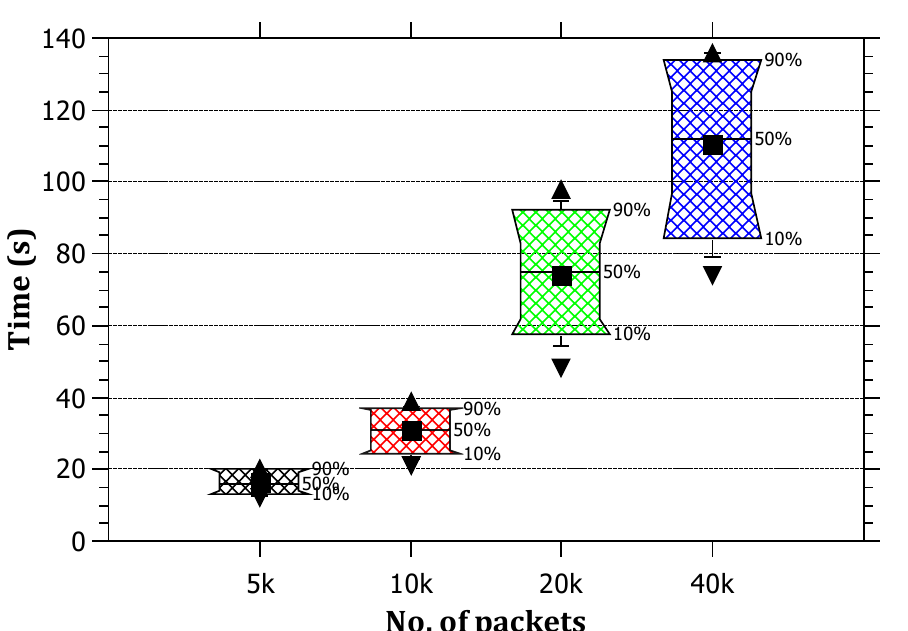
Figure 5. The relationship between the amount of traffic and the average detection time of the attack.